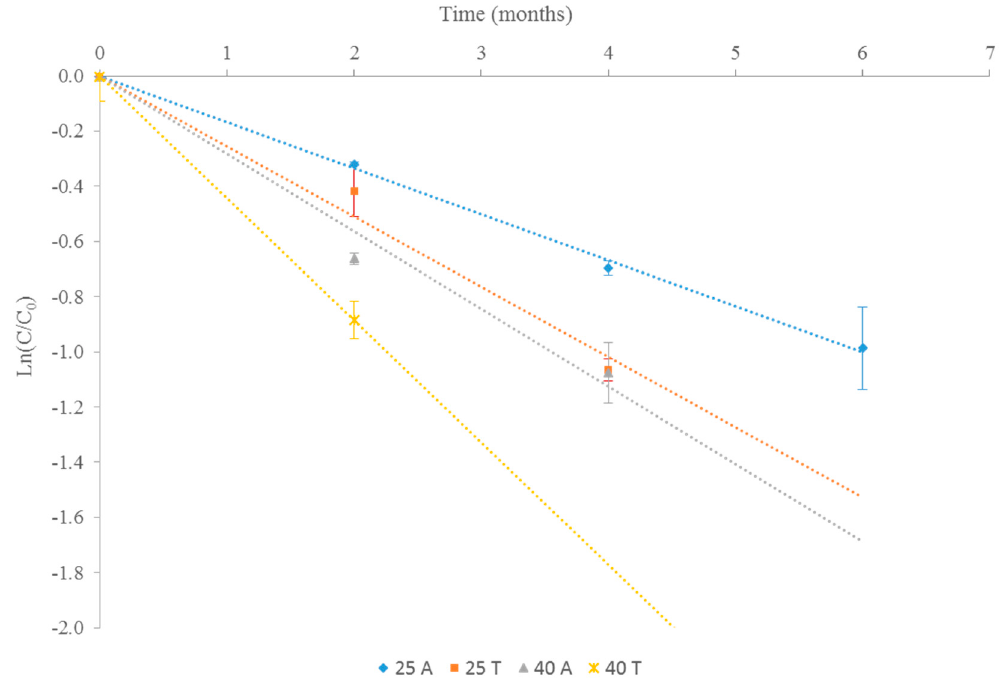
Figure 2. Anthocyanin degradation kinetic at different conservation conditions: : 25 ° C in amber vial (25A); : 25 ° C in transparent vial (25T); : 40 ° C in amber vial (40A); ×: 40 ° C in transparent vial (40T).